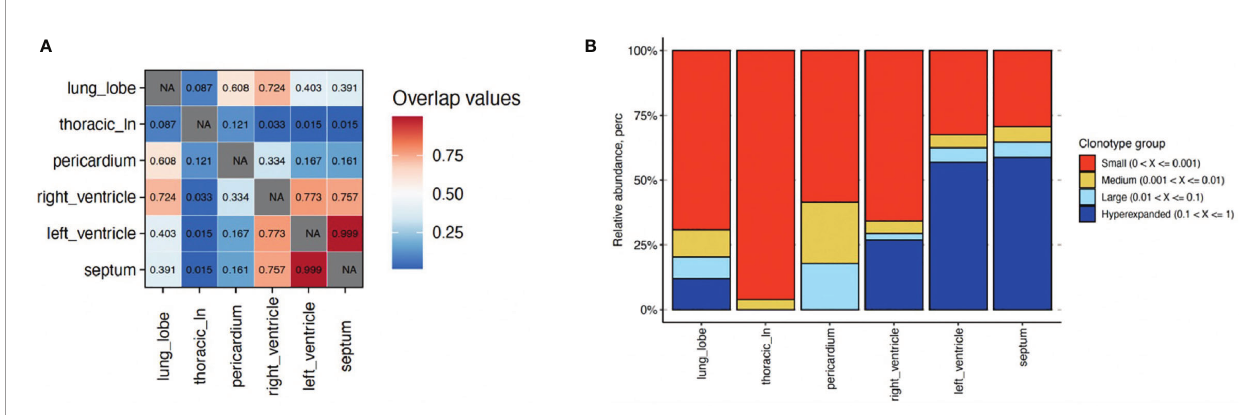
FIGURE 2 | Characterization of T cell clonotype abundance in cardiac tissues alongside lung and lymph node for comparison. (A) T cell repertoire overlap across tissues using Morisita indices (1&red=highest; 0&blue=lowest). (B) Percentage of T cell clonotypes with small (0-0.001, orange); medium (0.001-0.01, tan); large (0.01-0.1; light blue); and hyperexpanded (0.1-1; dark blue) frequencies across tissues. NA,